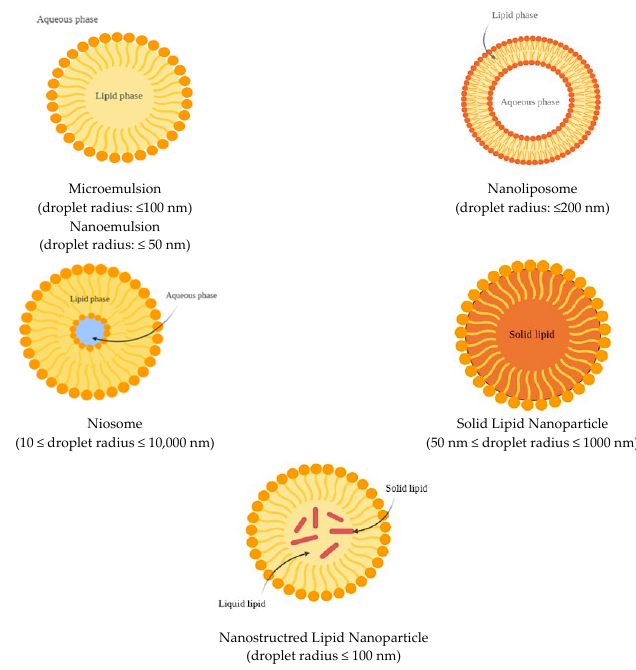
Figure 3. Schematic representation of lipid-based nanocarriers. Nanoemulsions are defined as emulsions characterized by a droplet radius ≤ 50